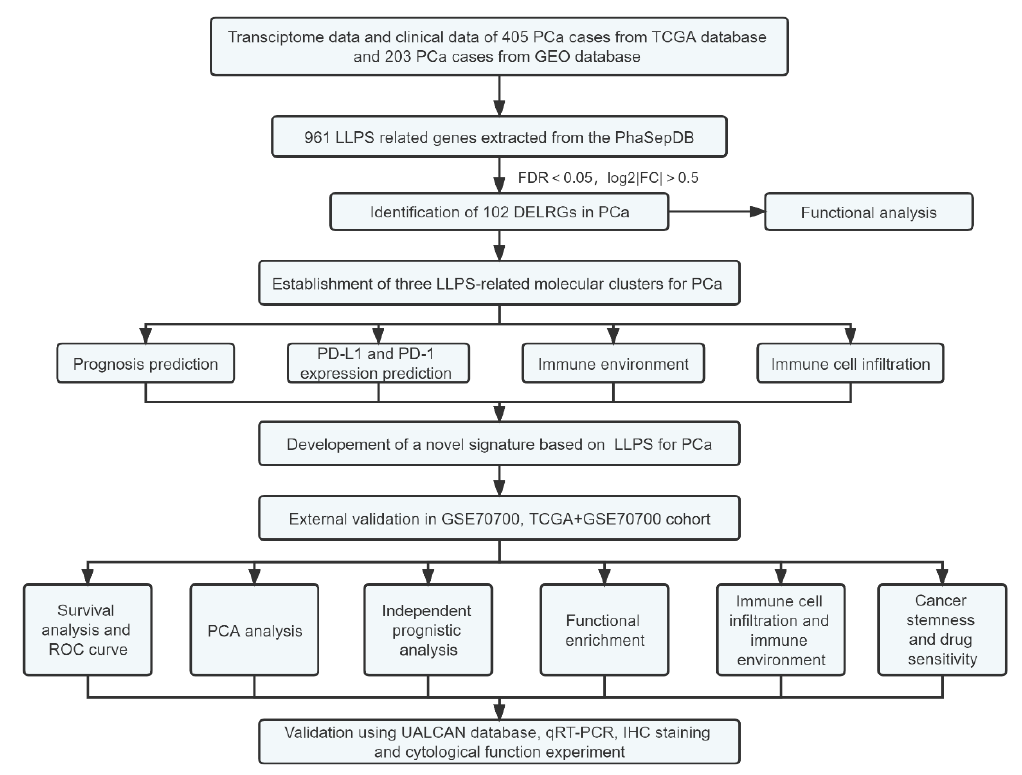
Figure 1. The flow diagram of our study.